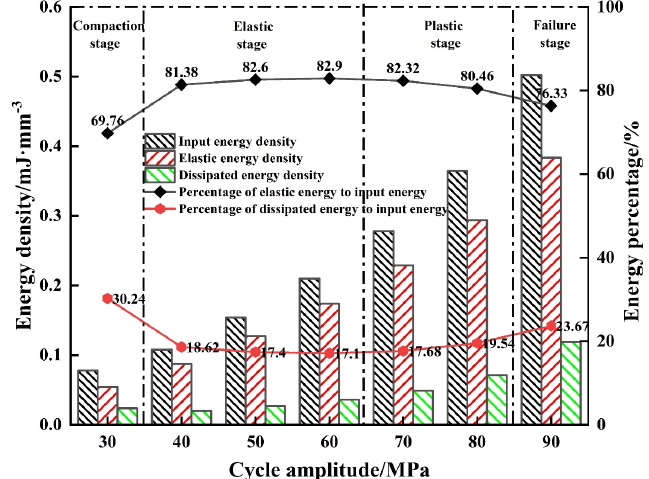
Figure 7. Energy transformation during the cyclic loading process.